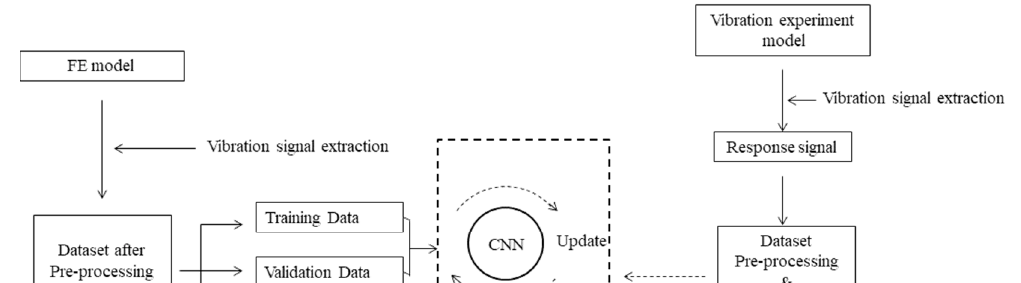
Figure 9. Normalization method.